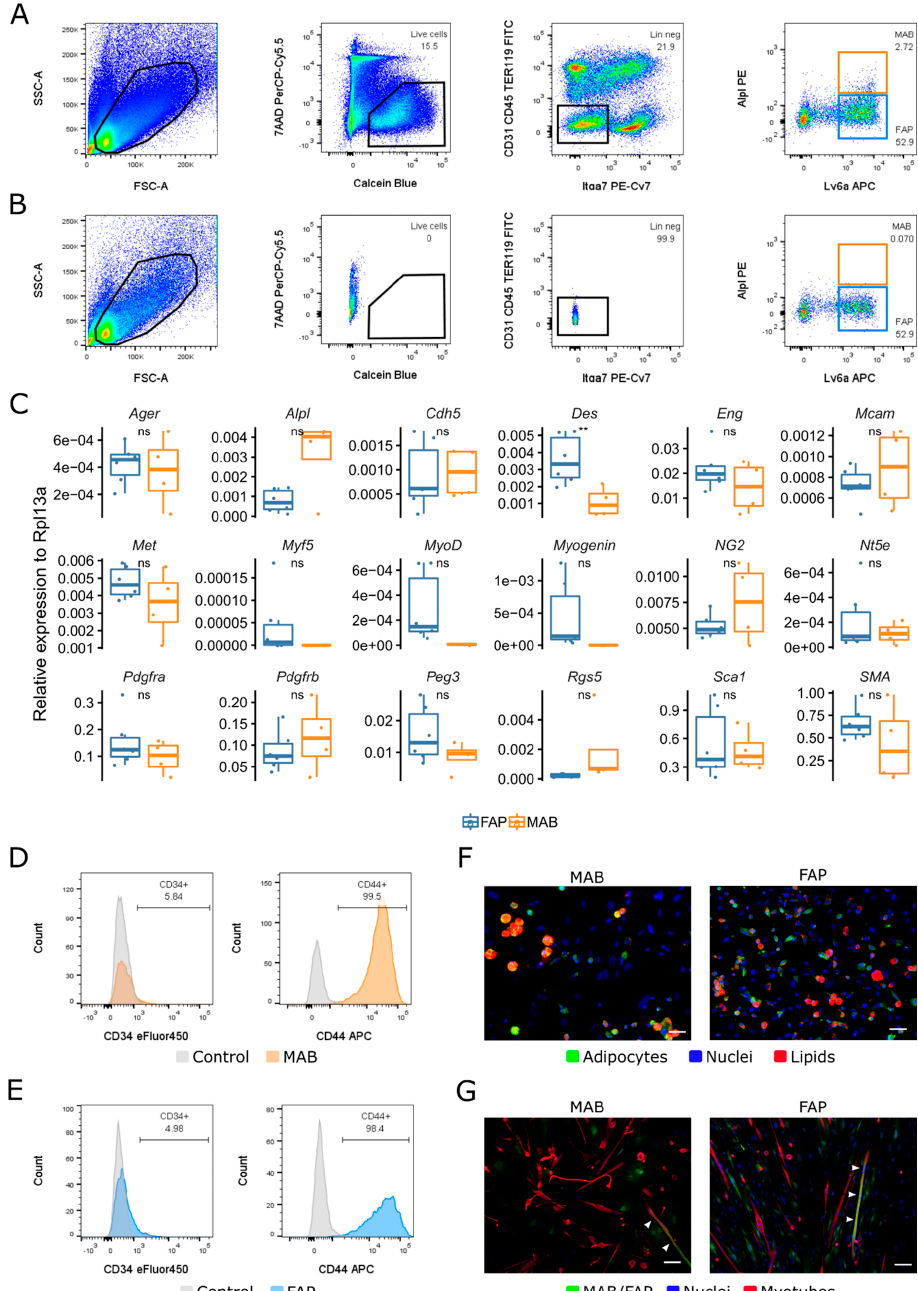
Figure 3. Isolation and characterization of interstitial stem cells from murine skeletal muscle. Gating strategy for FACS (fluorescent activated cell sorting) isolation of murine MABs (mesoangioblasts) and FAPs (fibro/adipogenic progenitors) ( A ) and control gates ( B ). ( C ) qPCR analysis of characteristic genes; values shown as relative expression to Rpl13a . n = 4–6. ( D , E ) Flow cytometry analysis of characteristic markers. MAB in orange ( D ), FAP in blue ( E ) and unstained control samples in grey. ( F ) Microscopy images of adipogenic differentiation; nuclei are stained with Hoechst (blue), lipids are stained with Oil Red O (red) and adipocytes are stained with Perilipin (green). ( G ) Microscopy images of myogenic differentiation from the co-culture of mouse MAB or FAP and satellite cells; Myotubes are stained with MyHC (red), MAB or FAP are stained with GFP (green) and nuclei are stained with Hoechst (blue). In ( E , F ), scale bar, 50 µ m. * p ≤ 0.05, ** p ≤ 0.01, t